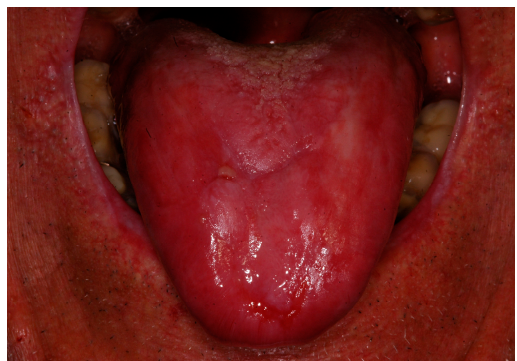
Figure 3. Clinical view of the patient after two months of treatment with platelet-rich plasma (PRP) oral rinses.